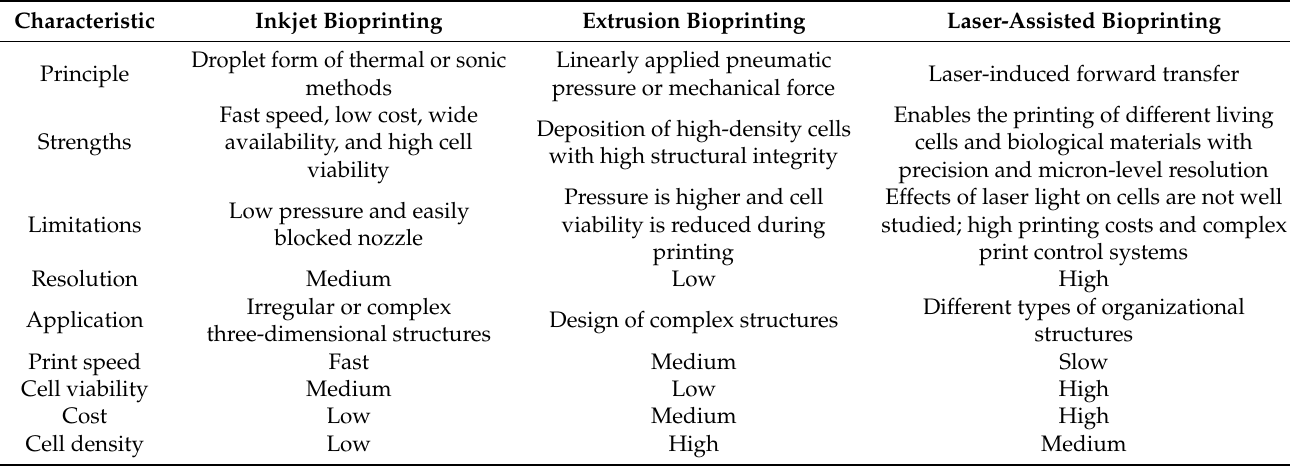
Table 1. Differences in various types of bioprinting processes [10–12].